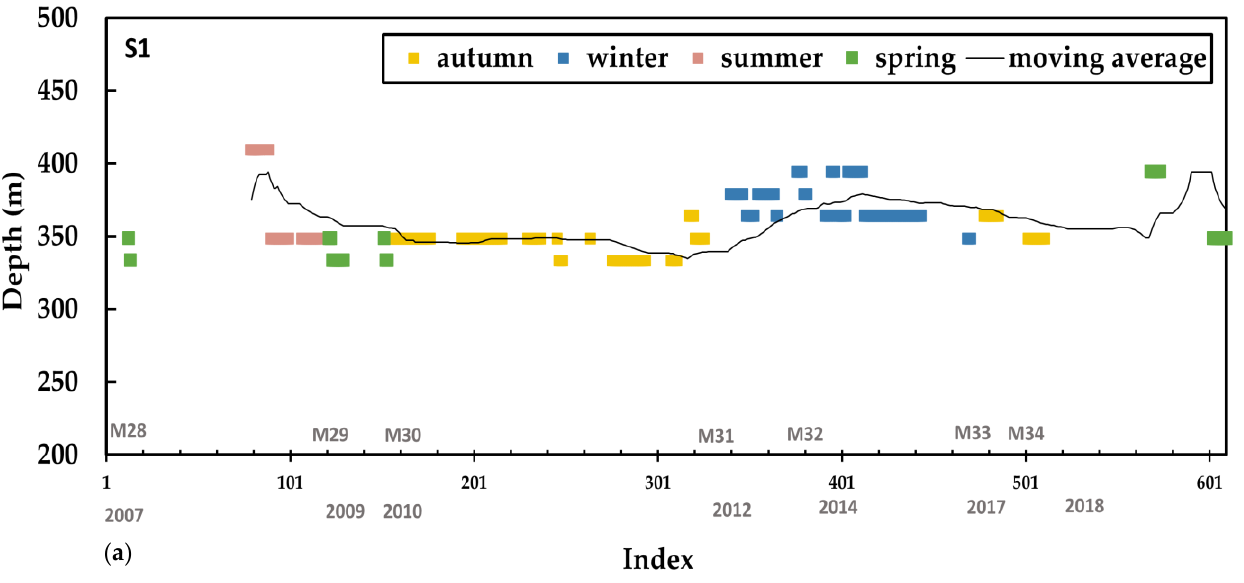
Figure 11. The thickness variations of shallow deposits through 11 terrestrial years (observation Figure 11. Cont period is from 2007 to 2018, the Martian year is M28–M34) in the study area of ( a ) S1, ( b ) S2, ( c ) S3. The horizontal axis presents the index of the SHARAD orbit ordered by the observation time, and the vertical axis shows the thickness of AA 3C . Moving average is the trend line with a period of 80.